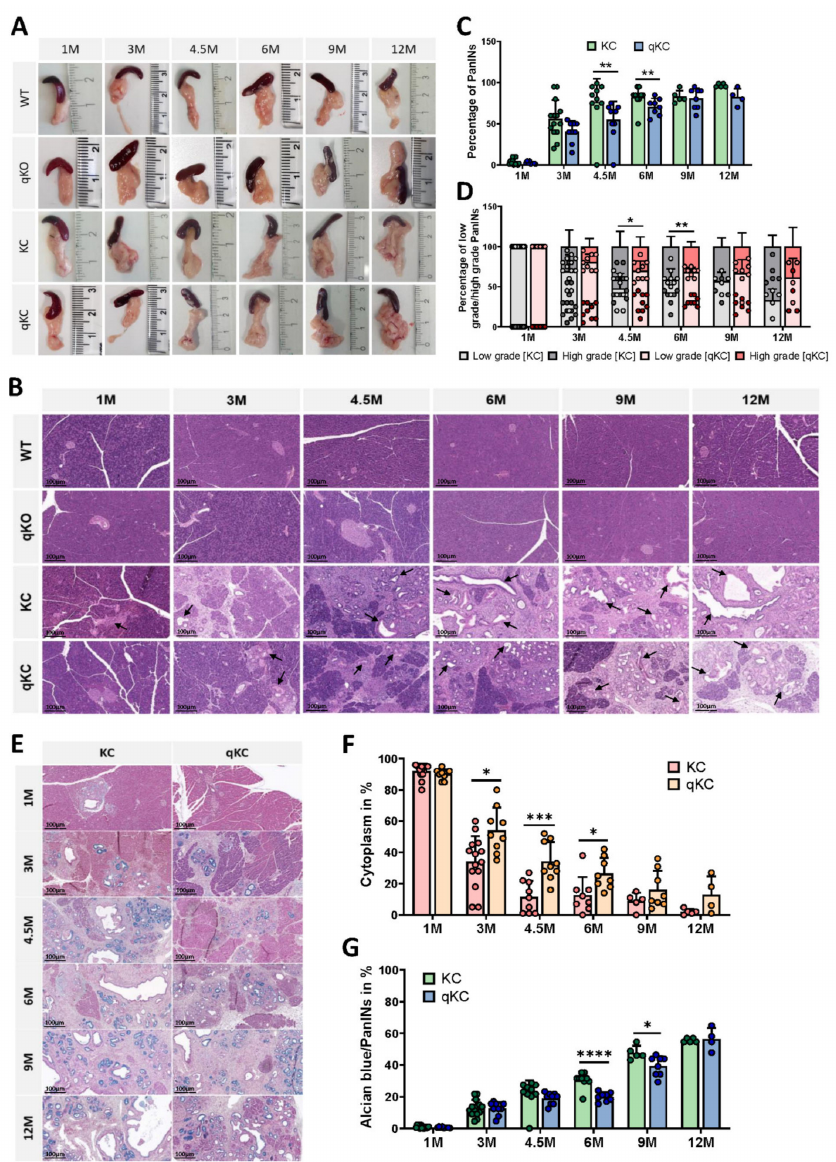
Figure 5. Deletion of POLQ affects tumor progression and differentiation in established pancreatic ductal adenocarcinoma in vivo. ( A ) Representative pancreases from 1 M, 3 M, 4.5 M, 6 M, 9 M, and 12 M WT, qKO, KC, and qKC animals. ( B ) Histology of the pancreas from age-matched wild- type, qKO, KC, and qKC mice at 1, 3, 4.5, 6, 9, and 12 months old. Arrows indicate PanIN lesions (hematoxylin and eosin stain; scale bars represent 100 µ m). ( C ) Percentage content of PanIN lesions and ( D ) their histologic progression in KC and qKC mice at the age of 1 month (KC, n = 14; qKC, n = 9), 3 months (KC, n = 14; qKC, n = 9), 4.5 months (KC, n = 10; qKC, n = 10), 6 months (KC, n = 9; qKC, n = 8), 9 months (KC, n = 5; qKC, n = 8), and 12 months (KC, n = 5; qKC, n = 4). Error bars represent mean ± SD; * p < 0.05, ** p < 0.01, (Student’s t -test). ( E – G ) Alcian blue staining was performed to visualize differentiation. ( E ) Mucin-rich PanINs lesions are depicted in blue, cytoplasm in light red, and nuclei in dark red. Representative images of the pancreas from age-matched KC and qKC mice at 1, 3, 4.5, 6, 9, and 12 months old are shown. Scale bars represent 100 µ m. Histological score of ( F ) cytoplasm and ( G ) PanINs in pancreas of KC and qKC animals at the age of 1 month (KC, n = 14; qKC, n = 9), 3 months (KC, n = 14; qKC, n = 9), 4.5 months (KC, n = 10; qKC, n = 10), 6 months (KC, n = 9; qKC, n = 8), 9 months (KC, n = 5; qKC, n = 8), and 12 months (KC, n = 5; qKC, n = 4). Error bars represent mean ± SD; * p < 0.05, ** p < 0.01, *** p = 0.0001, **** p < 0.0001 (Student’s t